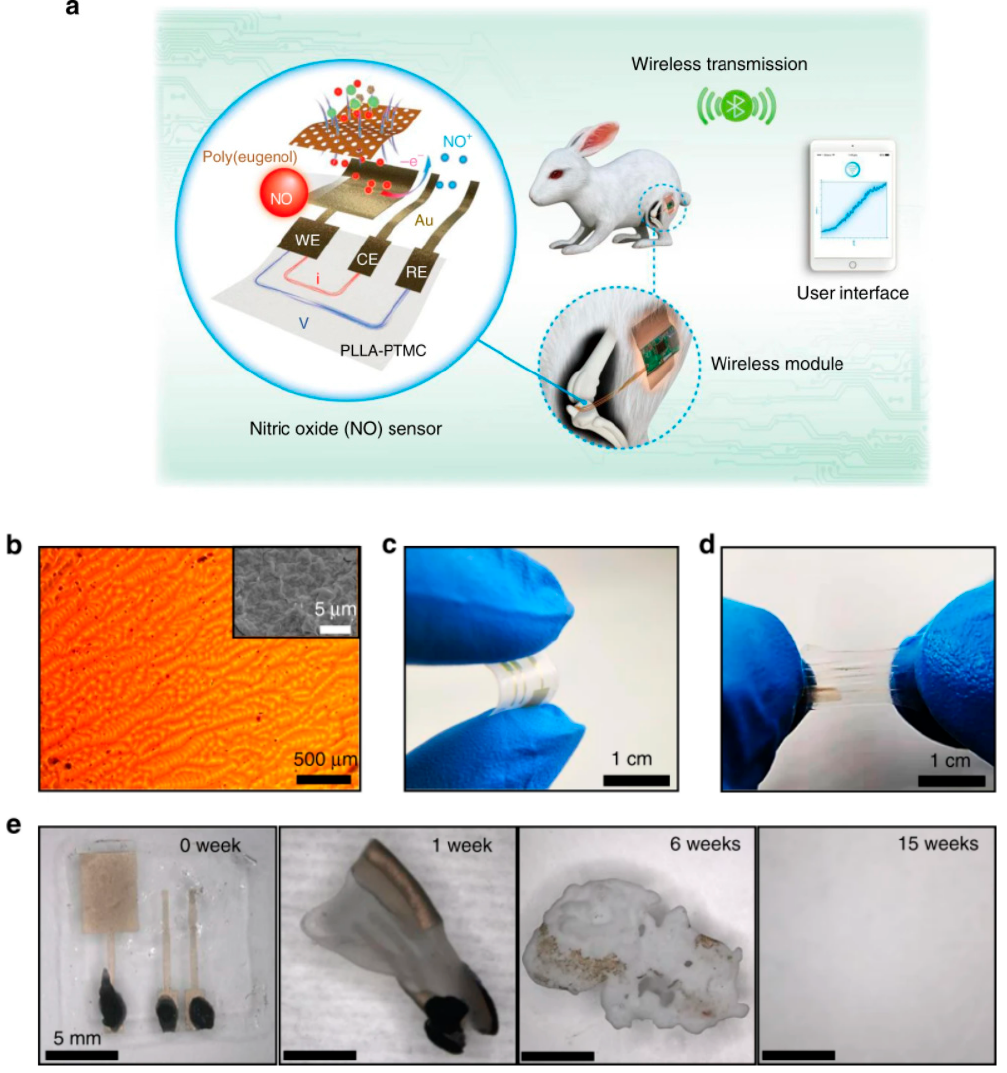
Figure 41. ( a ) Illustration of the bioresorbable NO sensor. The sensor is made of Au electrodes, poly(eugenol) and poly(L-lactic acid)–poly(trimethylene carbonate) (PLLA–PTMC) as substrate. NO concentration is measured by amperometry. The sensor is implanted in the joint cavity of rabbit. ( b ) Optical and SEM images of the surface morphology of Au electrodes bearing a poly(eugenol) film. ( c , d ) Pictures of the NO sensor upon bending and stretching. ( e ) Pictures of the sensor acquired during accelerated degradation in PBS at 65 °C. Adapted from [163], licensed under a Creative Commons Attribution 4.0 International License.